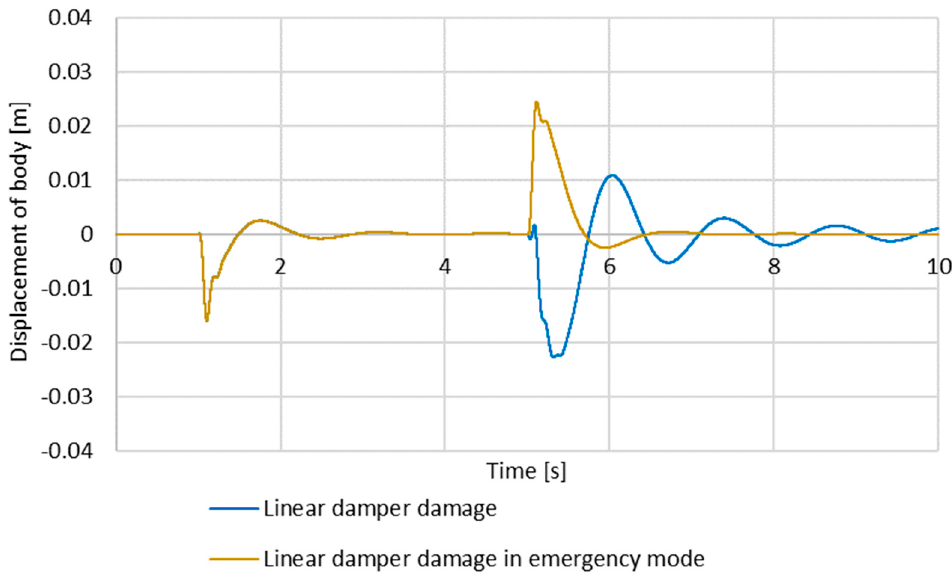
Figure 10. Body vertical displacement for a linearly damaged damper with introduction of an emergency mode.